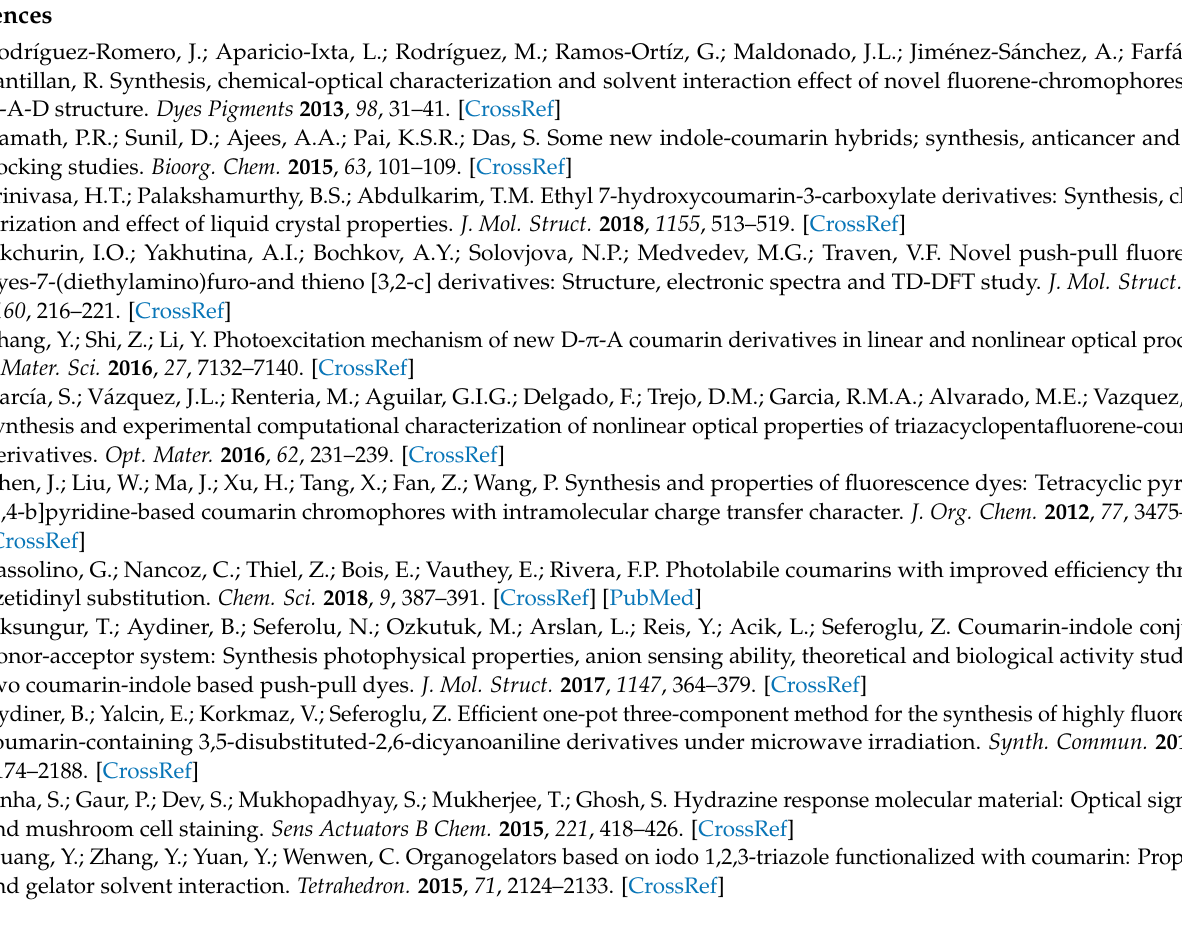
Figure S17, Powder X-ray diffractogram of 1a , b , d ; Table S1, HOMO-LUMO interactions of compounds 1b – d , Table S2, HOMO-LUMO interactions of compounds 2b – d